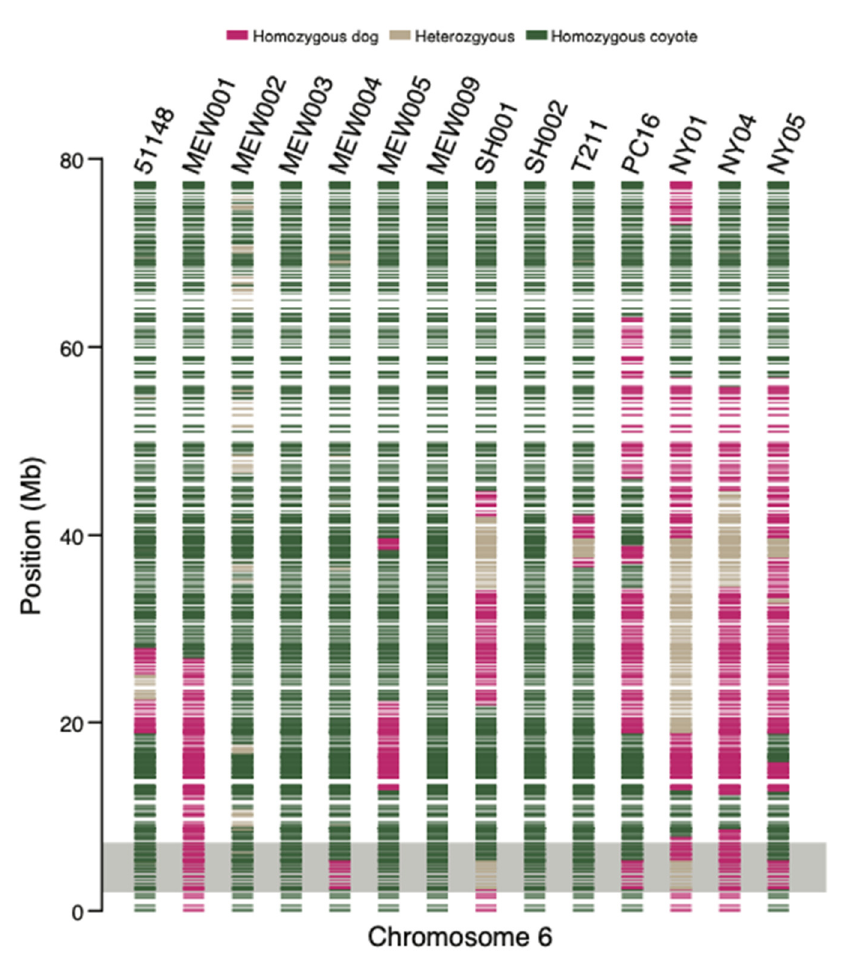
Figure 4. Ancestry blocks for canine chromosome 6. Each horizontal band is an ancestry block with the color of the block indicative of the ancestry state (homozygous or heterozygous) for the respective species identity. The chromosomal region highlighted by the gray box indicates the location of the hypersociability transposable element alleles.